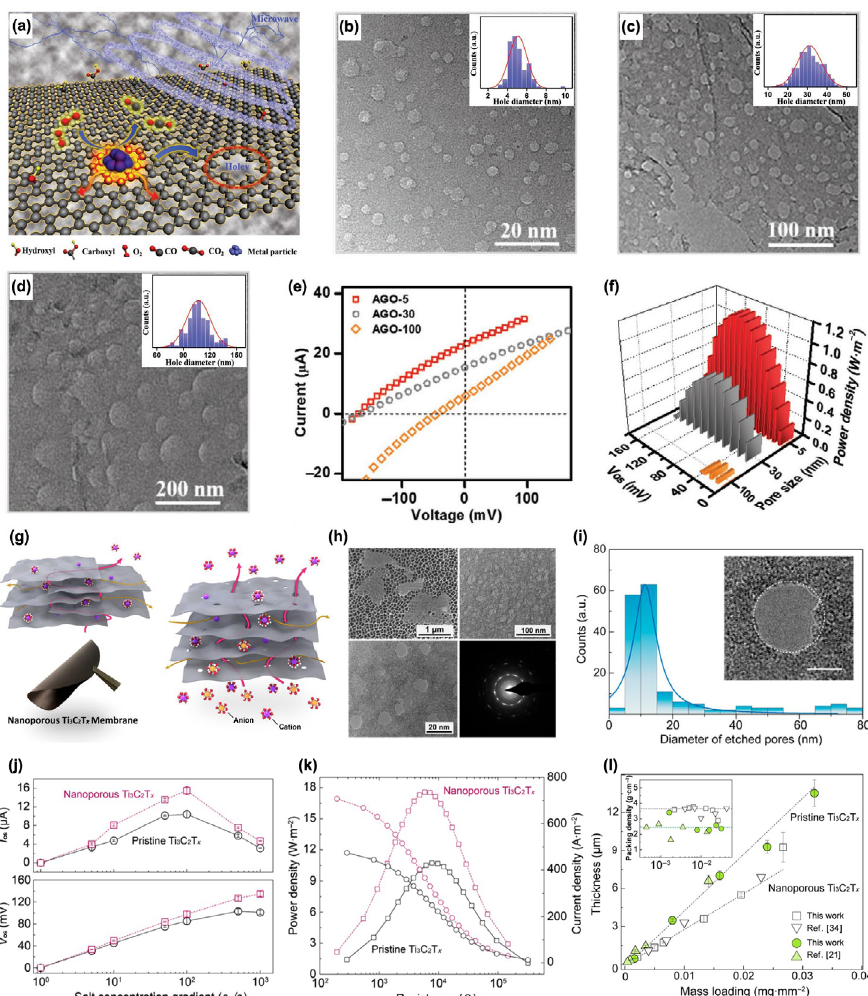
Figure 5 Mechanism of the fabrication process for porous graphene (a). HRTEM images of porous graphene with various sizes and the corresponding hole diameter distribution statistics (inset) for ~ 5 nm (b), ~ 30 nm (c), and ~ 100 nm (d). I–V curves for porous graphene membrane with a pore size of